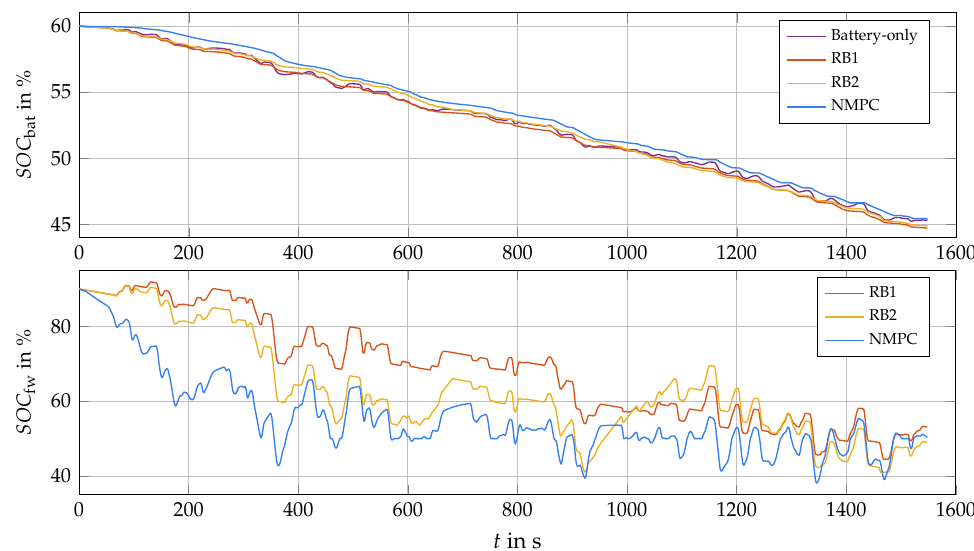
Figure 7. State of charge of battery SOC bat and KESS SOC fw along the E11 driving cycle for FW1. The lower part of Figure 7 shows the course of the flywheel SOC. It is noticeable that for the NMPC, the KESS comes close to its lower SOC limit much earlier than for the rule-based control strategies, but all of them finish close to each other at SOC fw 50%. Due ≈ to the implemented slack variable for the NMPC, it briefly falls below the lower limit of 41% at t 1350 s during a power peak before rising again. Nevertheless, the comparability ≈ between the rule-based controls and the NMPC is still given as this drop below the lower limit was very brief and hence the operating limits can be considered equal.